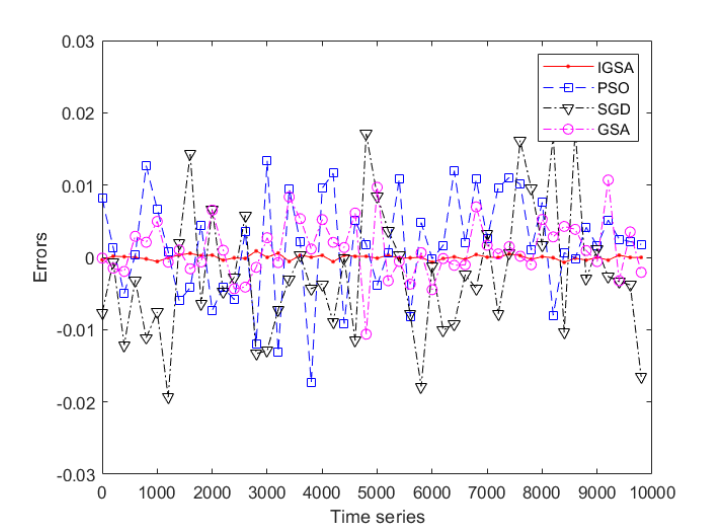
Figure 12. Predicted errors for the sine time series.